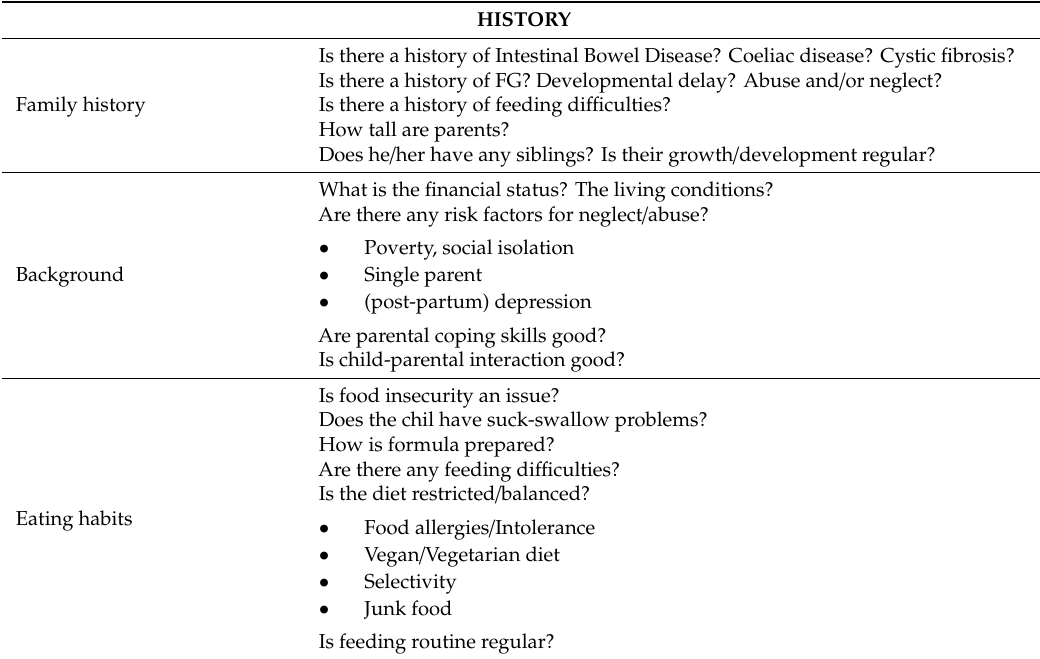
Table 2. Suggested evaluation of a patient with faltering growth (FG). In bold, alarm signs. BMI =